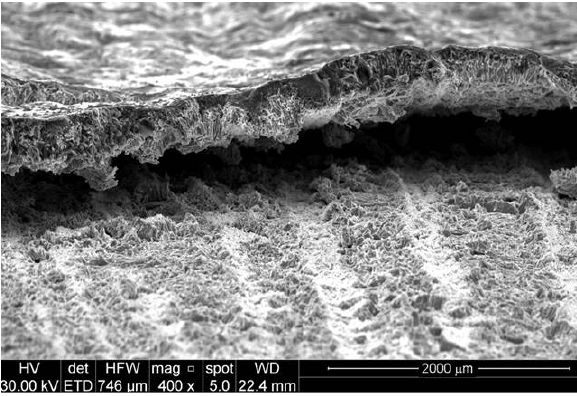
Figure 6: Layer thickness from a SEM